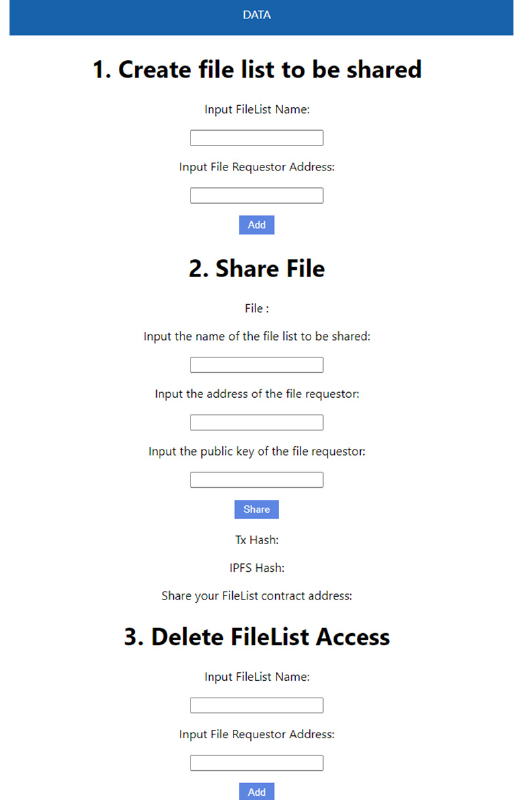
Figure 8. Share page.